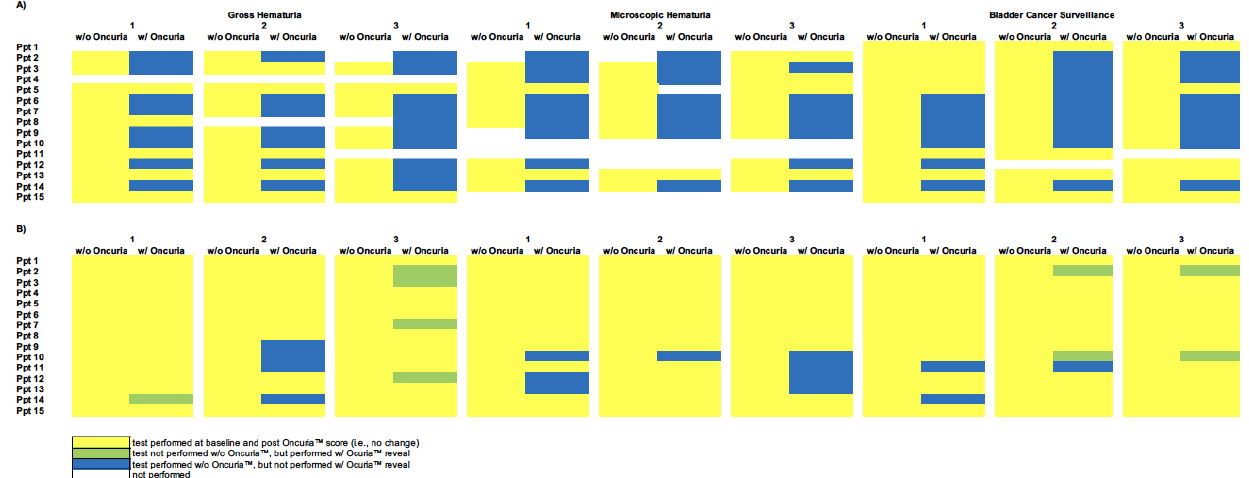
Figure 2. Heat maps representing the total number of diagnostic tests. This figure indicates the clinical decisions for the retrospective cases without (w/o) and with (w/ ) Oncuria™ results. Panel ( A ) baseline number of urine-based procedures and changes from baseline after presenting the results of Oncuria™. Rows represent participant physicians. Columns represent patients, w/o and w/Oncuria™ results. Each cell represents a patient– physician decision node. Yellow represents baseline decision and no change after disclosing Oncuria™ score. Green represents test not performed prior to Oncuria™ results disclosure but performed w/Oncuria™ results disclosure. Blue represents test performed prior to Oncuria™ results disclosure, but not performed w/Oncuria™ results disclosure. White indicates that no test was performed. Panel ( B ) baseline number of invasive and/or imaging procedures and changes from baseline after presenting the results of Oncuria™. Rows represent participant physicians. Columns represent patients, w/o and w/ Oncuria™ results. Each cell represents a patient – physician decision node. Yellow represents baseline decision and no change after disclosure Oncuria™ score. Green represents test not performed prior to Oncuria™ data disclosure but performed w/Oncuria™ data disclosure. Blue represents test performed prior to Oncuria™ results disclosure, but not performed post-Oncuria™ results disclosure. White indicates that no test was performed.